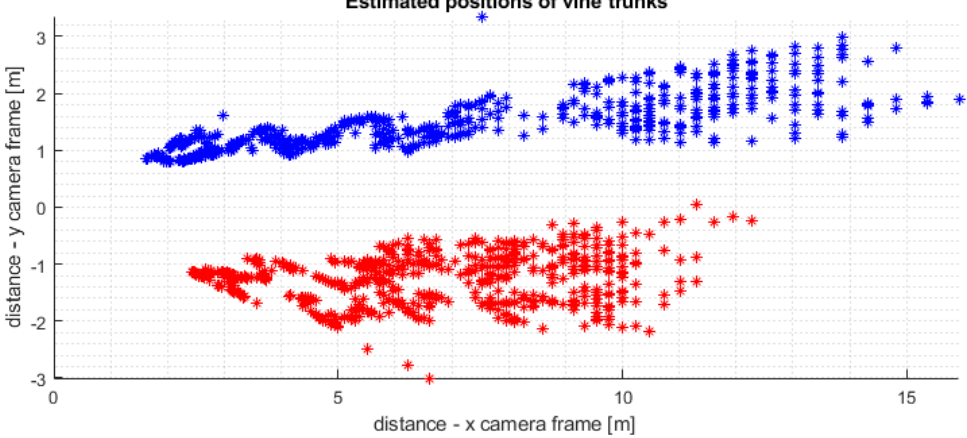
vine trunk in the next aisle.